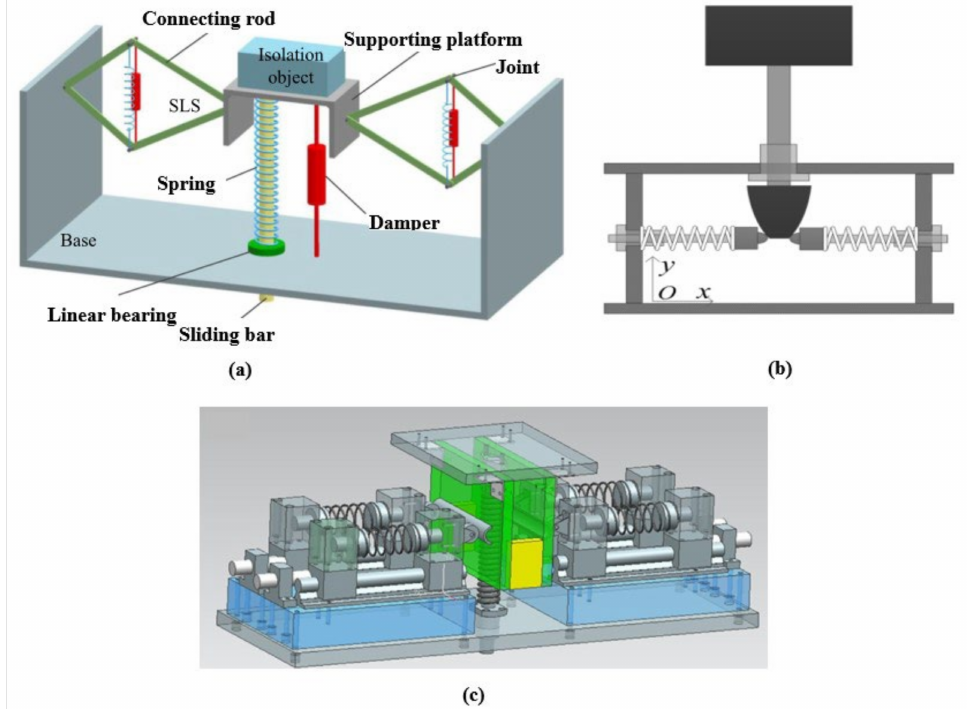
Figure 9. Geometrically nonlinear vibration isolation structure in ( a ) QZS isolator structure of shear type structure, ( b ) QZS isolator for cam mechanism and ( c ) Cam-roller-spring QZS isolator structure. Reprinted/adapted with permission from Ref. [77]. Copyright Springer-V erlag GmbH Germany, part of Springer Nature 2020, Wei Zou and Chun Cheng. Reprinted/adapted with permission from Ref. [78]. Copyright 2020 Published by Elsevier Ltd., Ming Li and Wei Cheng. Reprinted/adapted with permission from Ref. [79]. Copyright 2015 Elsevier Ltd., Jiaxi Zhou and Xinlong Wang.